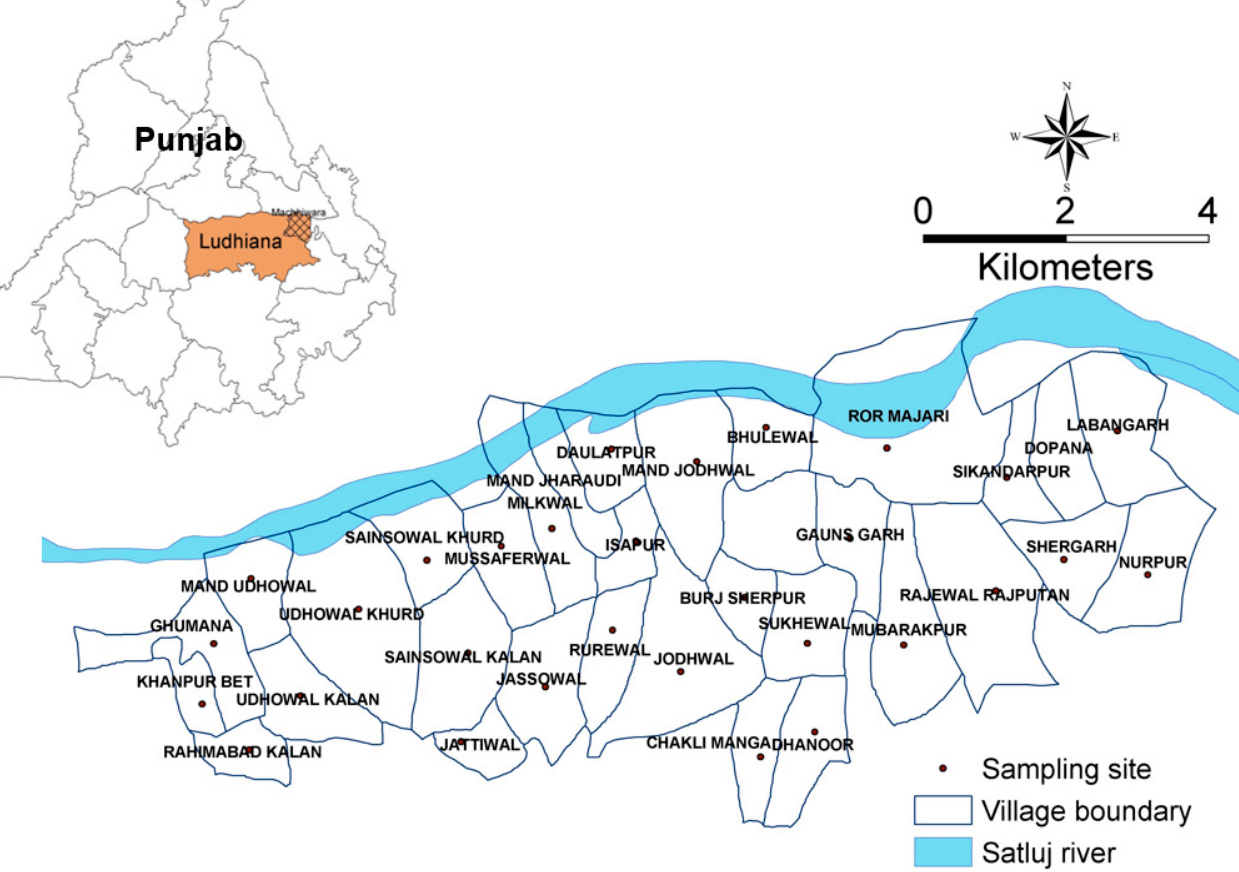
Figure 1. Location map of Machhiwara area with sampling sites. Table 1. Values of hydraulic parameters used for the SWAP-ANIMO simulation.